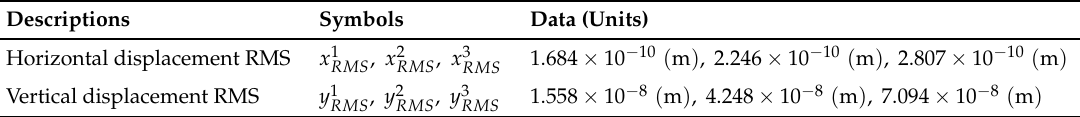
Table 4. State-space trajectory root-mean-square deviations for different sets of initial